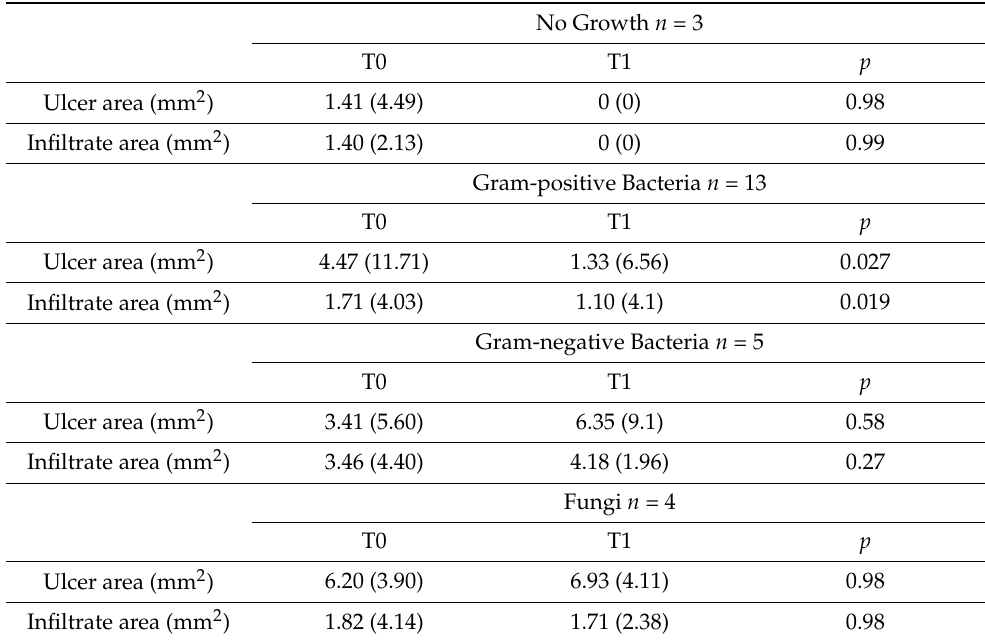
Table 1. Median (IQR) results of both ulcer and infiltrate areas at T0 and T1 for each category after microbial testing results.